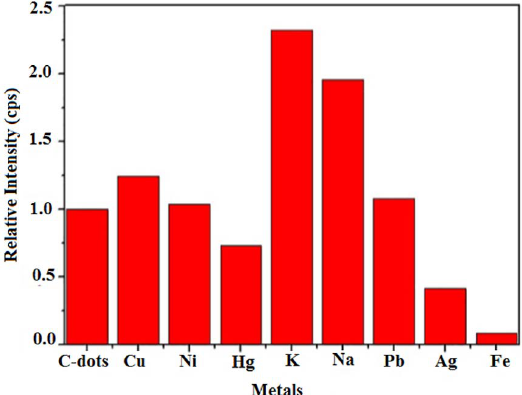
Figure 7. Performance of optical sensors based on as-prepared C-dots: comparison of fluorescence intensities in the absence and presence of different metal